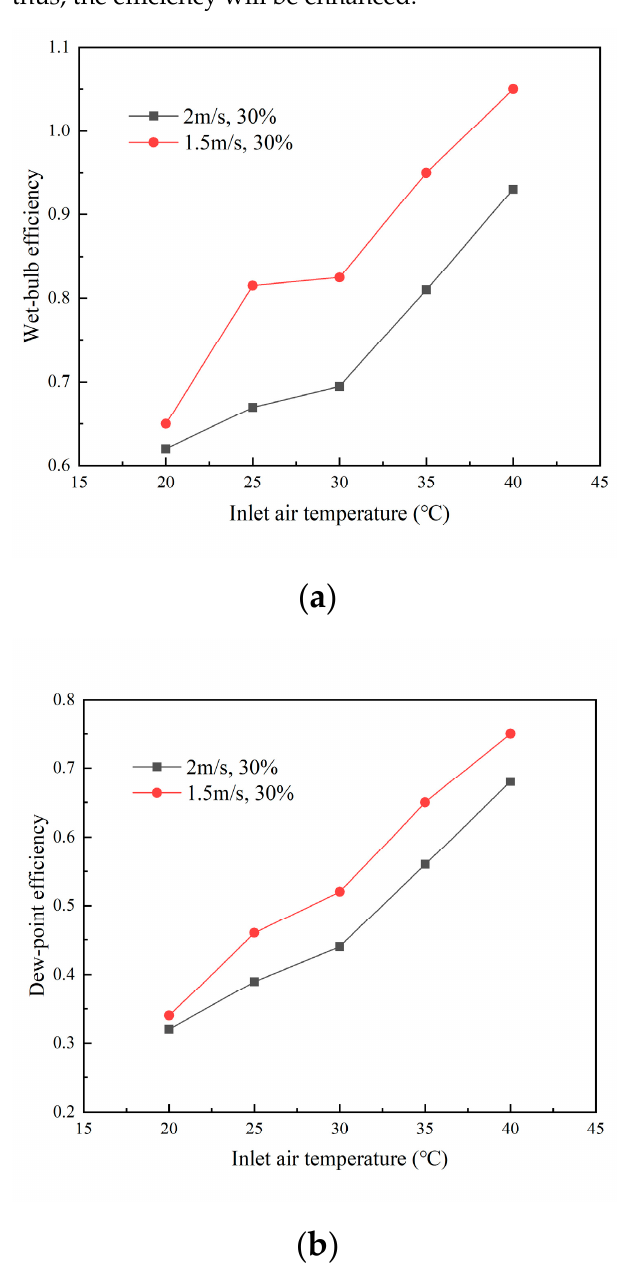
Figure 14. ( a ) Wet-bulb efficiency under different inlet air velocities and ( b ) dew-point efficiency under different inlet air velocities.